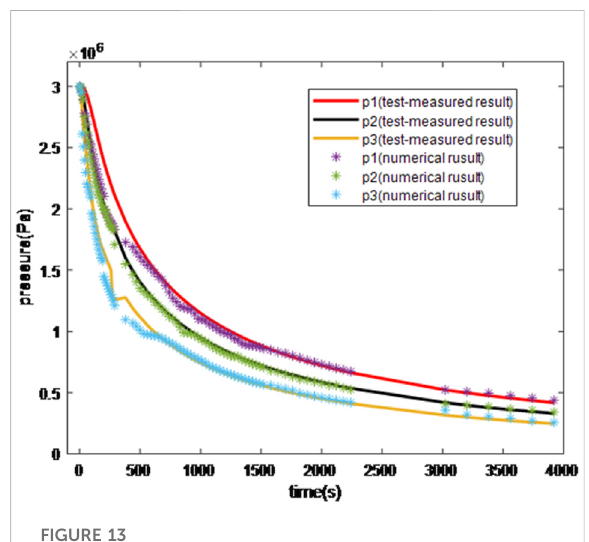
FIGURE 13 Comparison of the pore pressure and measured